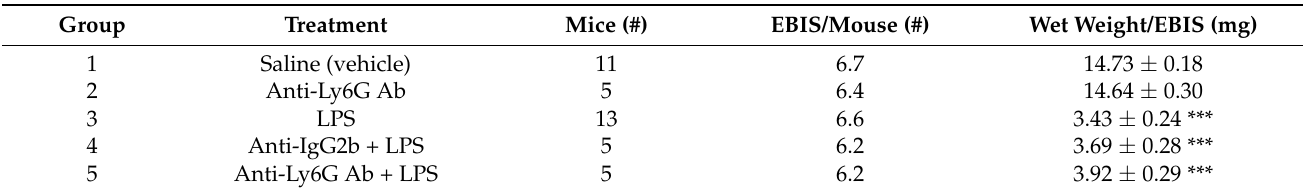
Table 1. Neutrophil depletion failed to protect LPS-induced implantation site defects. # number; *** p < 0.005, Significatly different from group